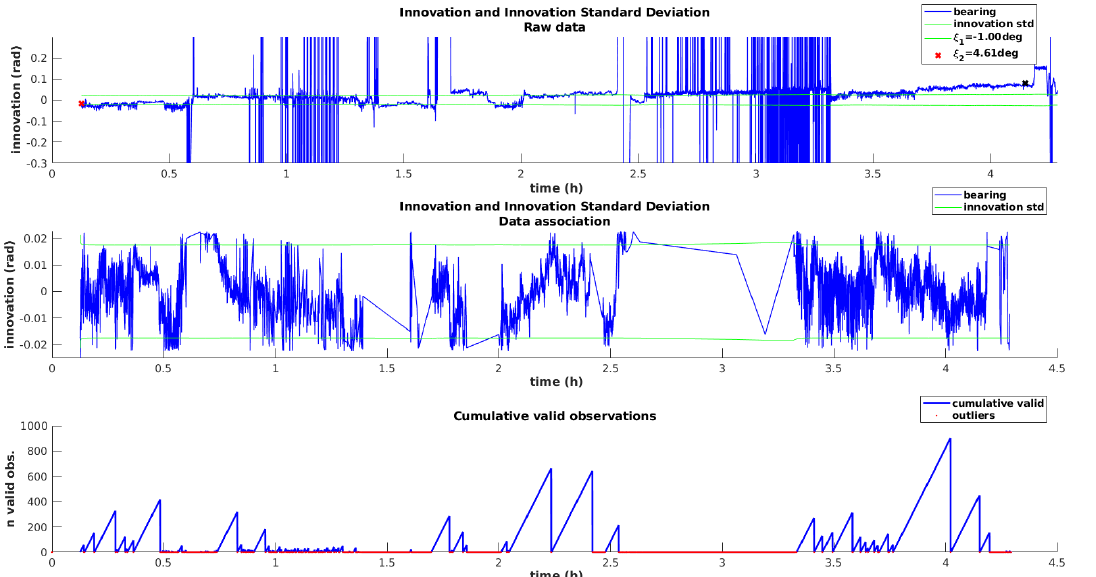
Figure 13. Performance analysis of the iUSBL observation model and data association method. ( Top ) Simulation of the innovation for the bearing observations, considering iUSBL observations with outliers. ( Middle ) Real innovation sequence obtained by introducing bearing observations in the data fusion stream and by performing data association. ( Bottom ) Cumulative representation of the consecutive observations accepted by the outlier rejection